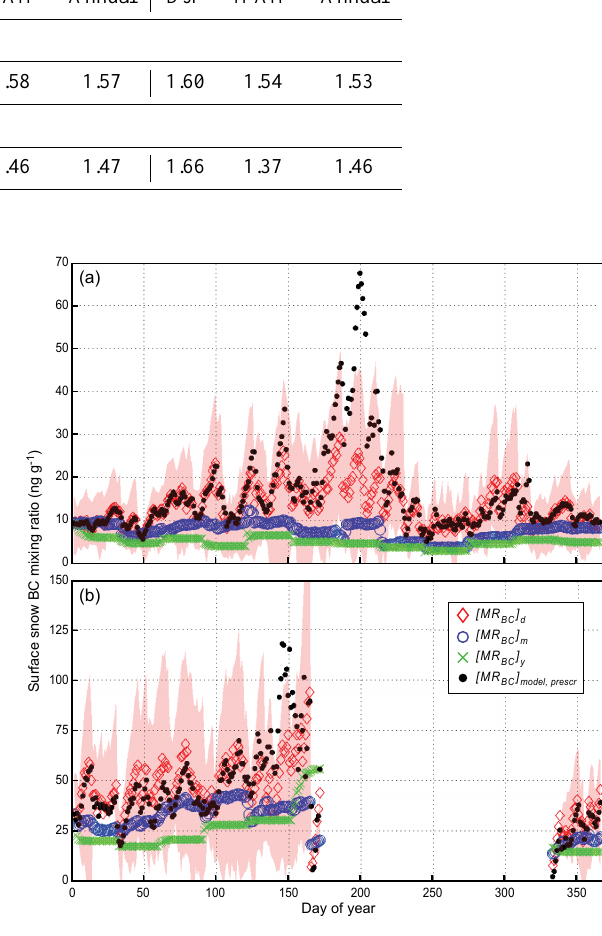
Figure 3. Surface snow BC mixing ratios (MR BC ) for (a) the Dye- 2 grid box shown in Fig. 1a and Fig. 2 and (b) the same northern Eurasia grid box shown in Fig. 1b. Shown are the average (red dia- monds) and standard deviation (red shaded area) across 10 years of [MR BC ] d from the offline computation using CESMmet and 10-year averages of MR BC values from CESM-CAM4 runs us- ing prescribed-aerosol deposition fields, [MR BC ] model,prescr (black dots). The CESM-CAM4 values (black dots) include the effects of snow-water loss to sublimation and melting, whereas the offline calculations (red) do not. Also shown are [MR BC ] m (blue circles) and [MR BC ] y (green x) from the offline calculation, again using